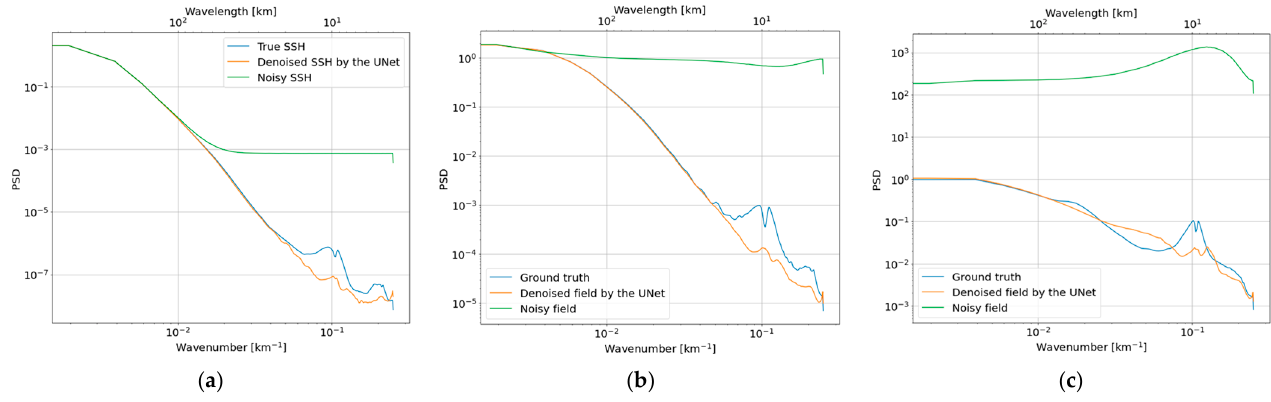
Figure 15. PSD of SSH ( a ), geostrophic current ( b ) and relative vorticity ( c ) of the Glorys model. The ground truth is in blue, the field denoised by the U-Net is in orange and the noisy field is in green. The PSD is computed from the average of each along-track PSD over the Glorys domain and on the test dataset (from the 1st July 2015 to the 31st December 2015).